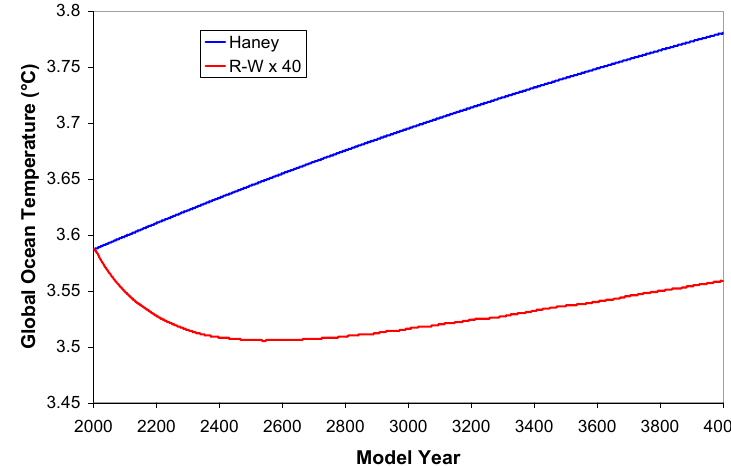
Figure 1. Time history of global ocean temperature from MITgcm with different ocean-atmosphere thermal boundary conditions.